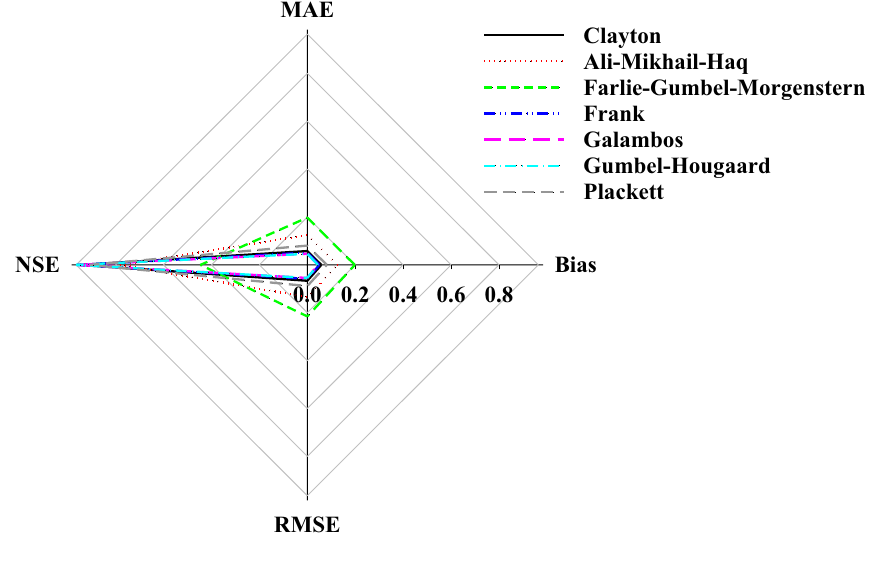
Fig. 6 Results of comparing the different copula function in 2D analyzing of AMD and MDR